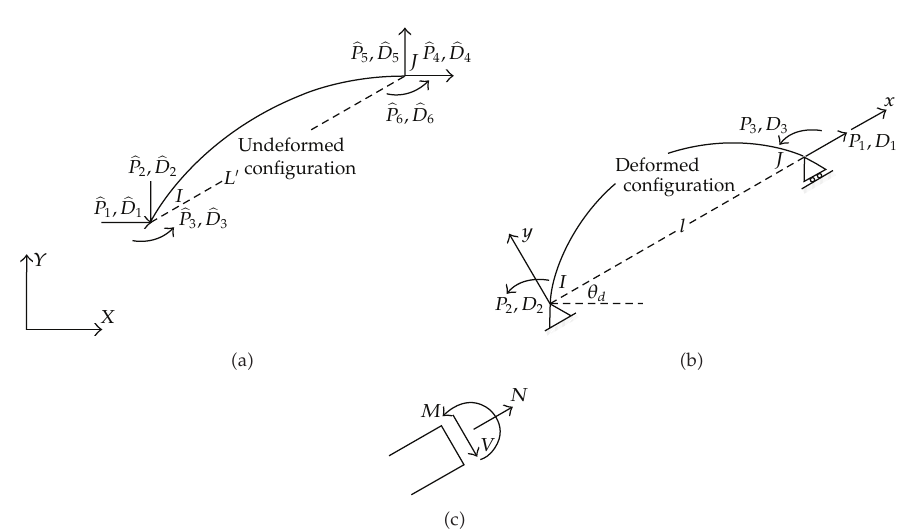
Figure 1: (cid:3) a (cid:4) Global coordinate system and degrees of freedom for a planar undeformed curved element. (cid:3) b (cid:4) Local adopted coordinate system without rigid body modes in element deformed state. (cid:3) c (cid:4) Force vector components on a sample